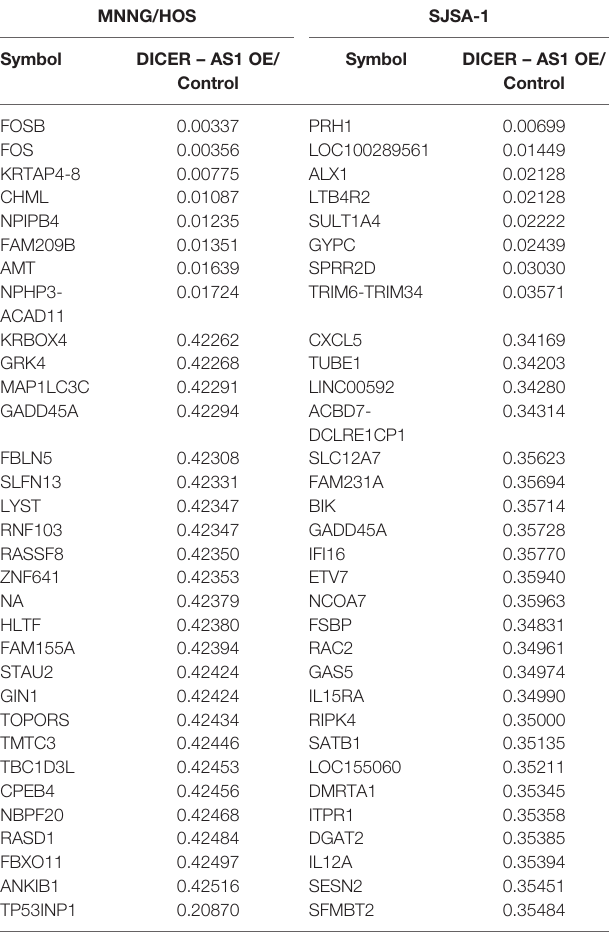
TABLE 2 | GADD45A expression in SJSA-1 and MNNG/HOS cells.